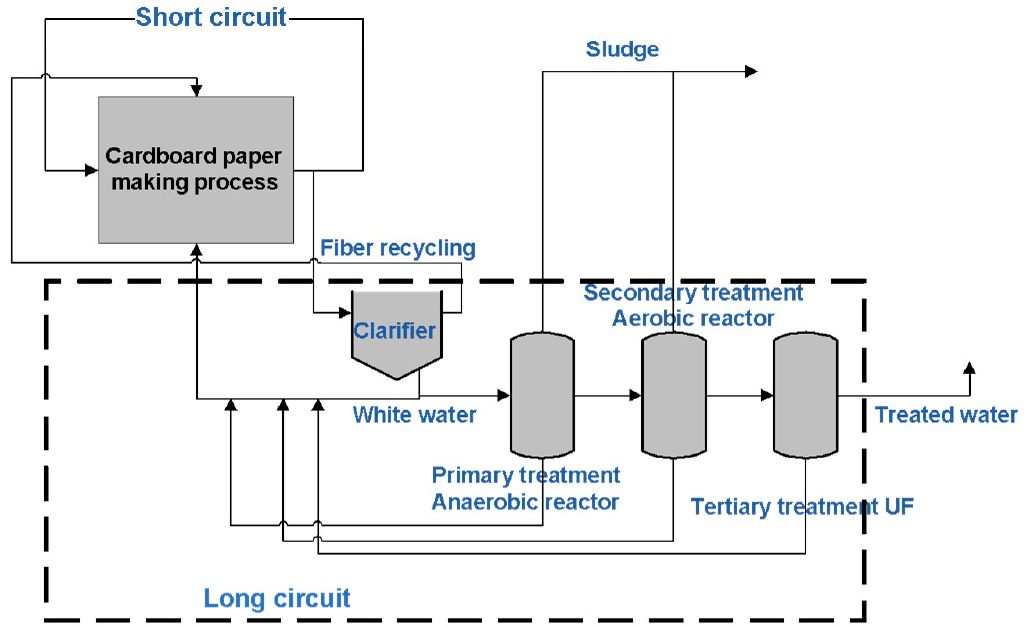
Figure 1. Flow chart of the recovery process of water in the cardboard papermaking process.